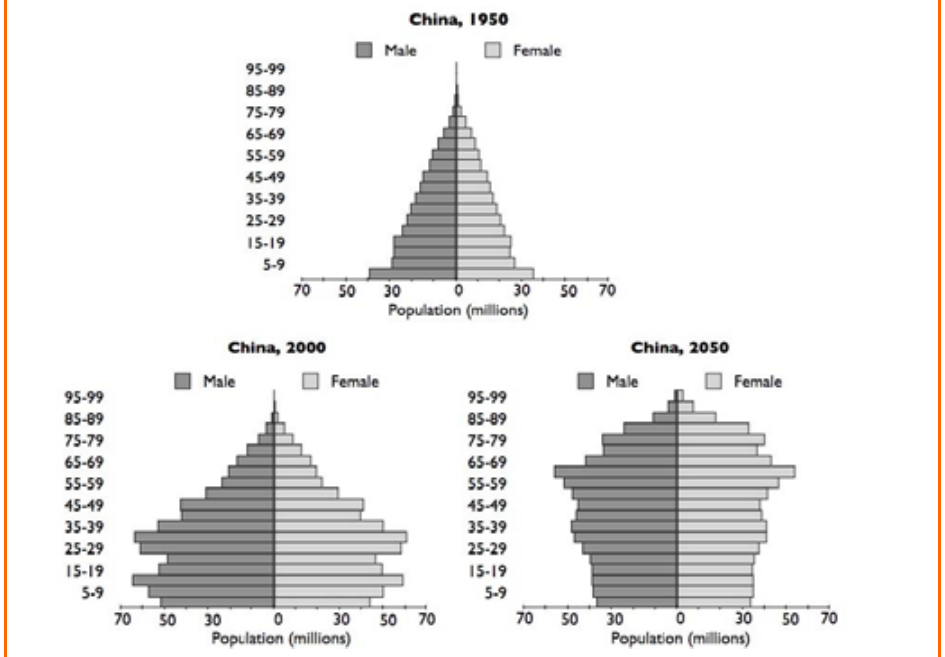
Figure 1: Population Pyramids for China (Data Source: United Nations World Population Prospects: 2008